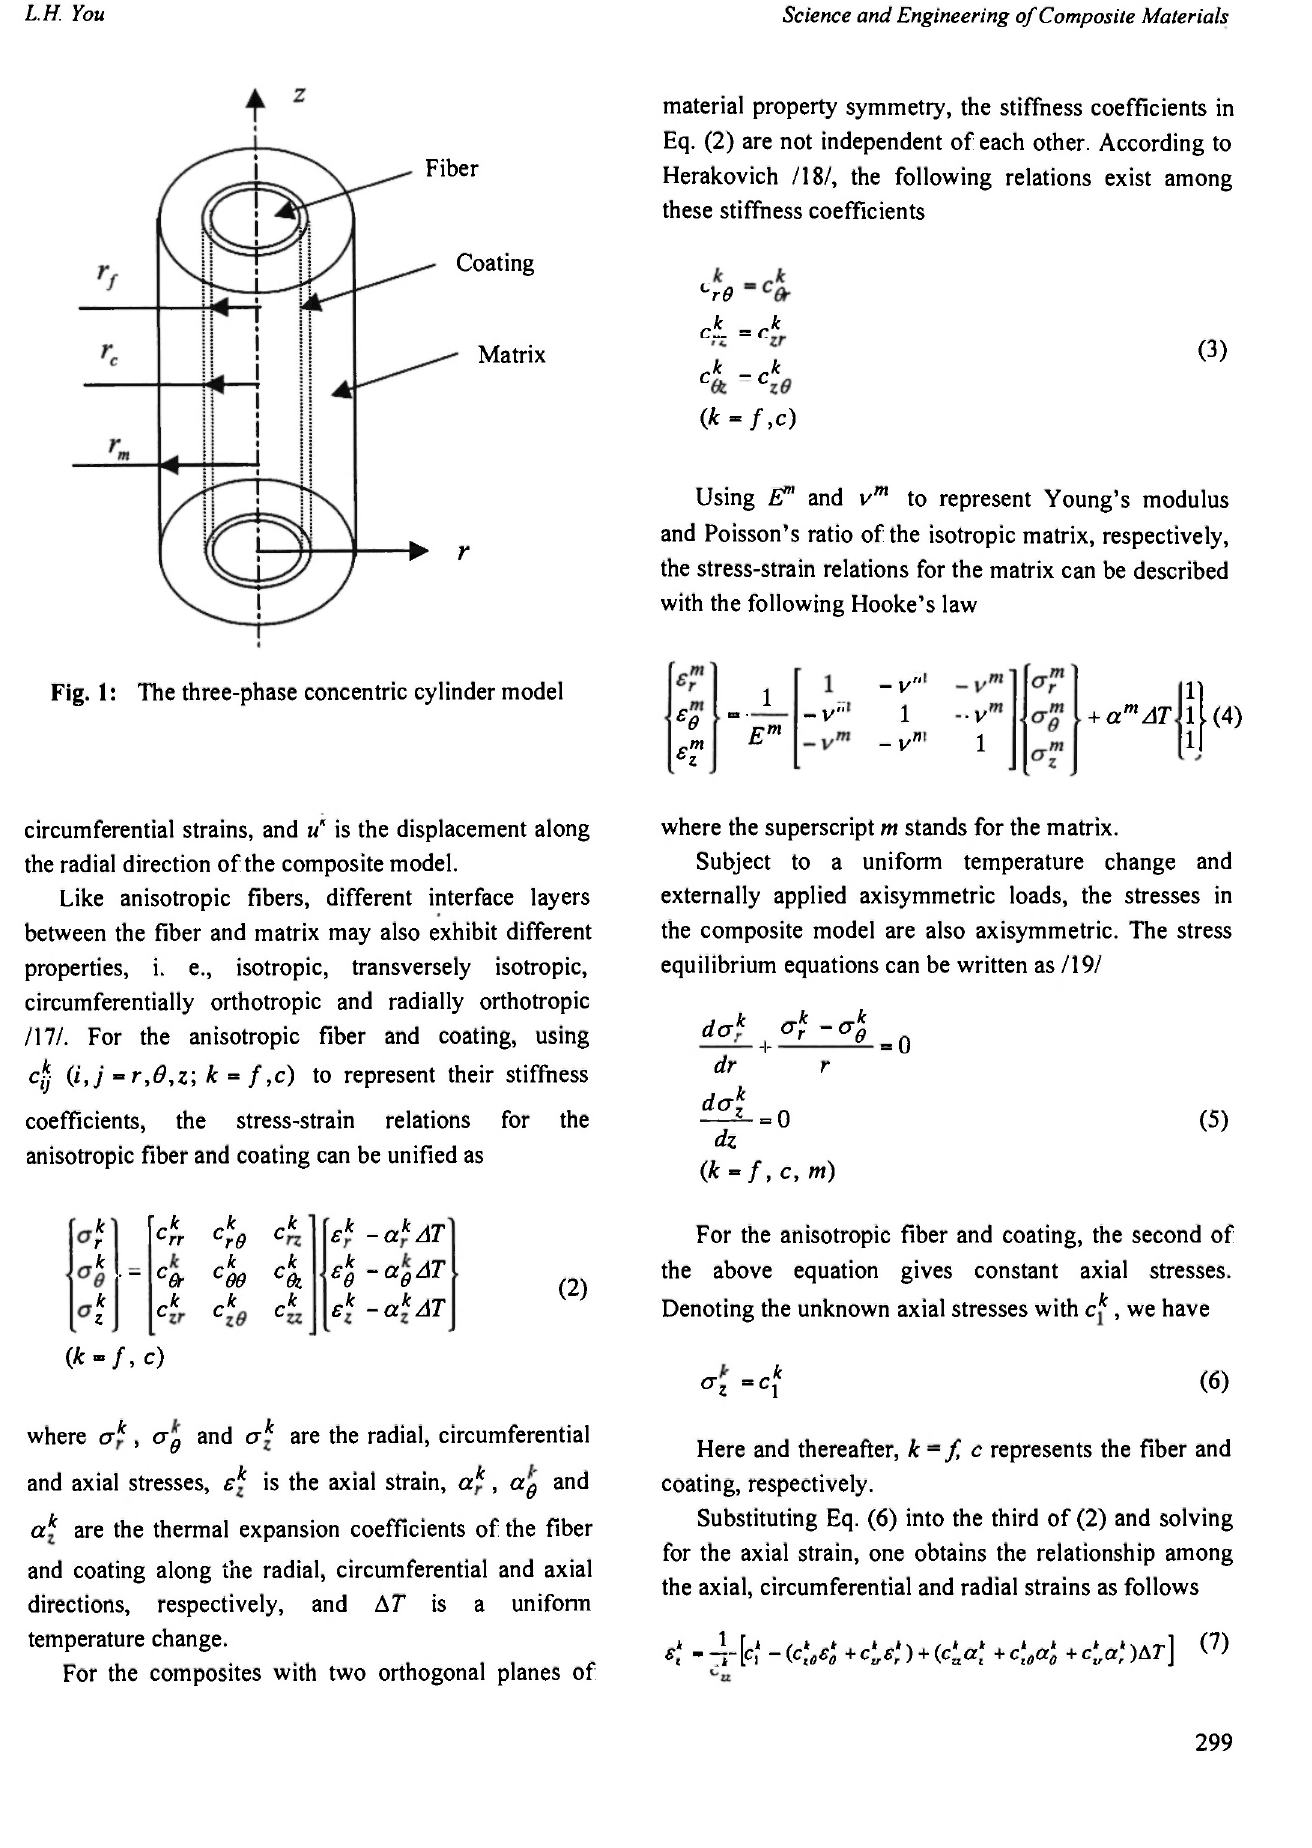
material property symmetry, the stiffness coefficients in Eq. (2) are not independent of each other. According to these stiffness coefficients